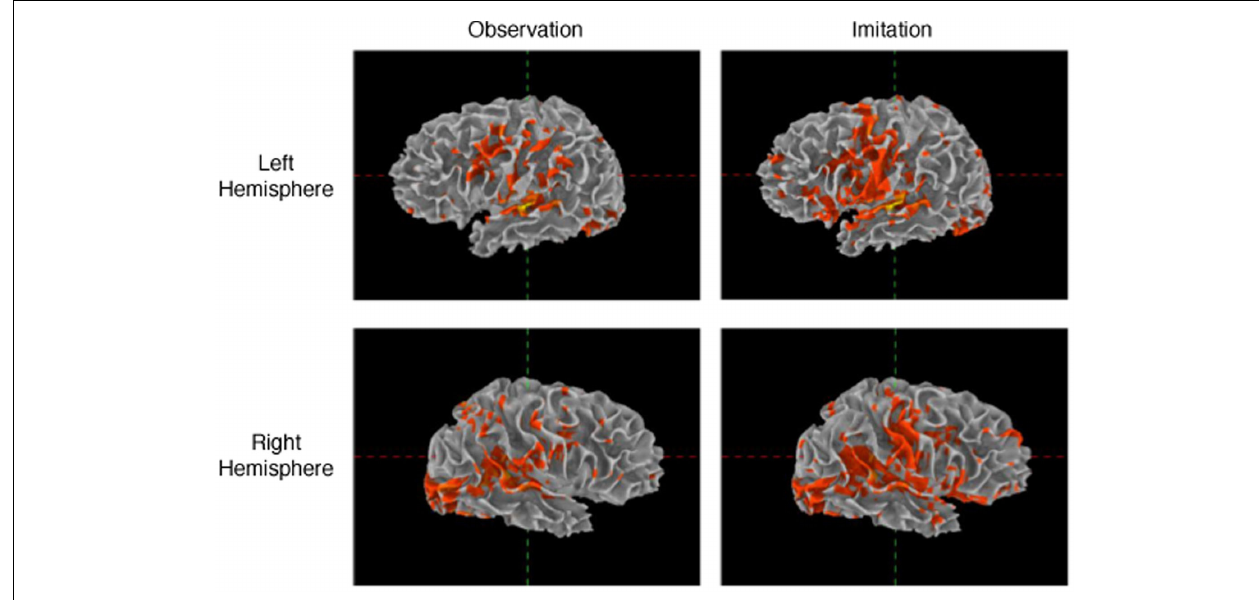
FIGURE 1 |Activation during observation and imitation. Voxels were selected using general linear model after adjusting for false positives using false discovery rate ( p < 0.05).The figure shows the data obtained from a representative single subject.